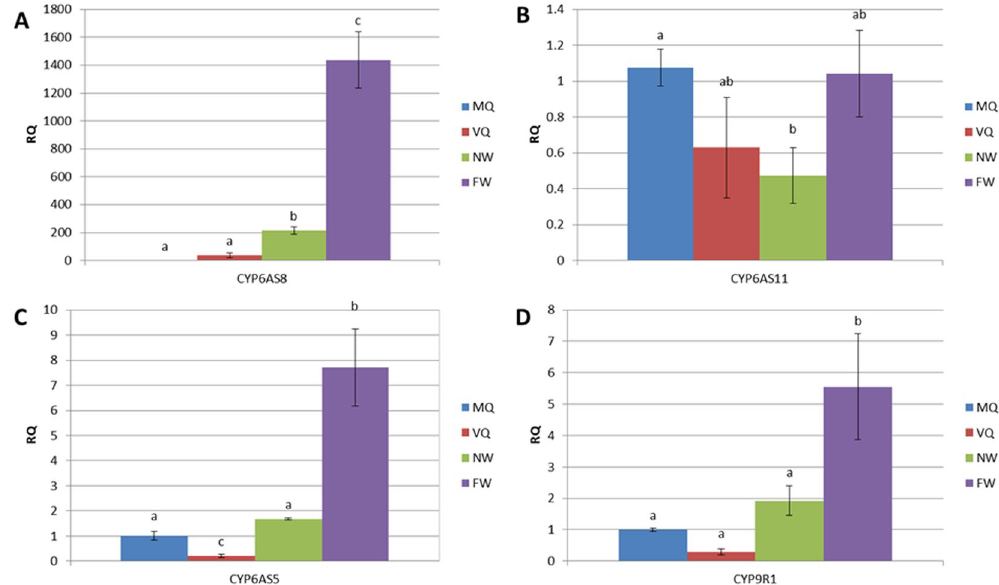
Figure 5. Expression levels of CYT P450 genes among castes and physiological groups. ( A ) the expression of CYP6AS8 in MGs. ( B ) the expression of CYP6AS11 in MGs. ( C ) the expression of CYP6AS5 in legs. ( D ) the expression of CYP9R1 in legs. RQ, fold change in gene expression. Error bars represent SD fold changes. Different letters represent significant difference between groups ( p <